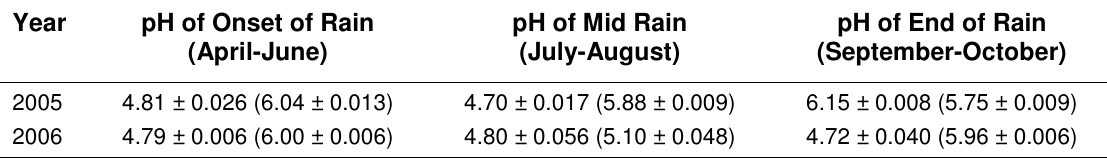
pH of Rainwater Samples in Warri between April and October, 2005 and